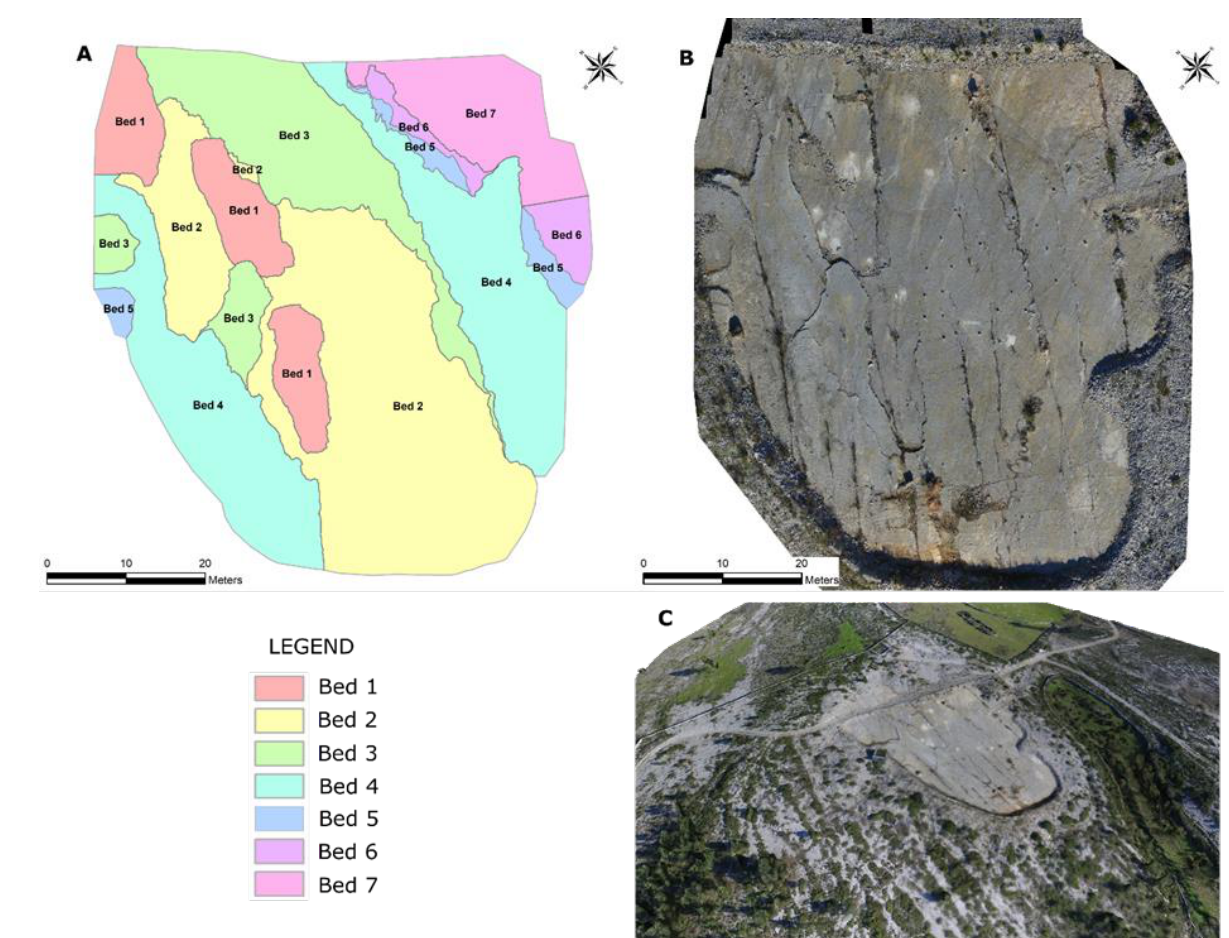
Figure 2. Vertical and oblique views of the former quarry of Cabeço da Ladeira. ( A ) Mapping of the seven different beds identified on the studied geosite, ( B ) orthophoto of the geosite for comparison, and ( C ) oblique view of the textured 3D model of the geosite and the main accesses after the Environmental Recovery Plan.